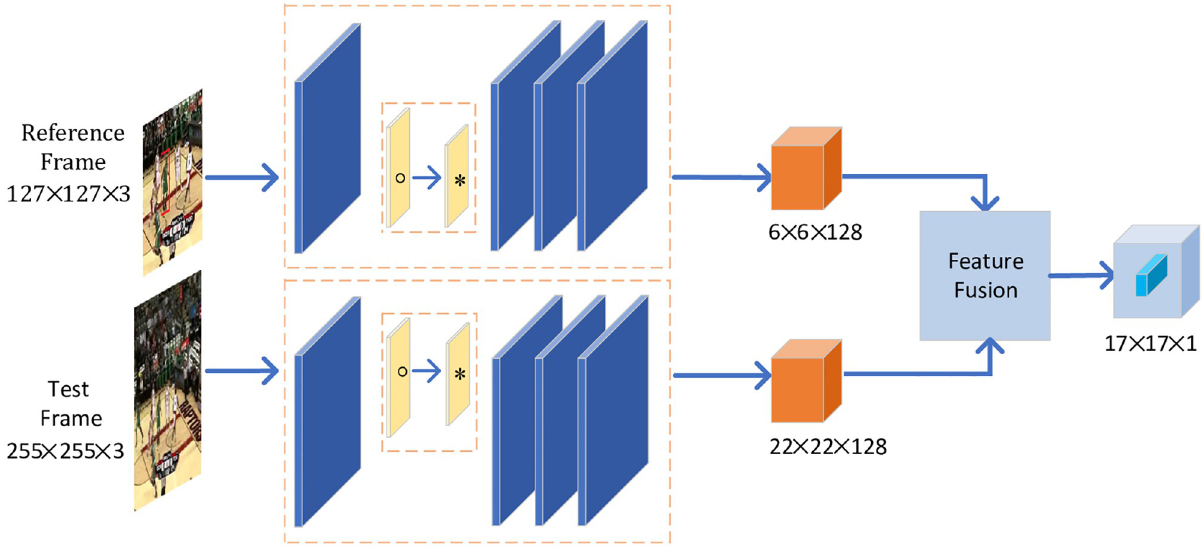
Fig 2. Illustration of DOSiam. It consists of the feature extraction subnetwork and cross-correlation operation. The feature extraction subnetwork contains conventional convolution layers and DO-Conv.